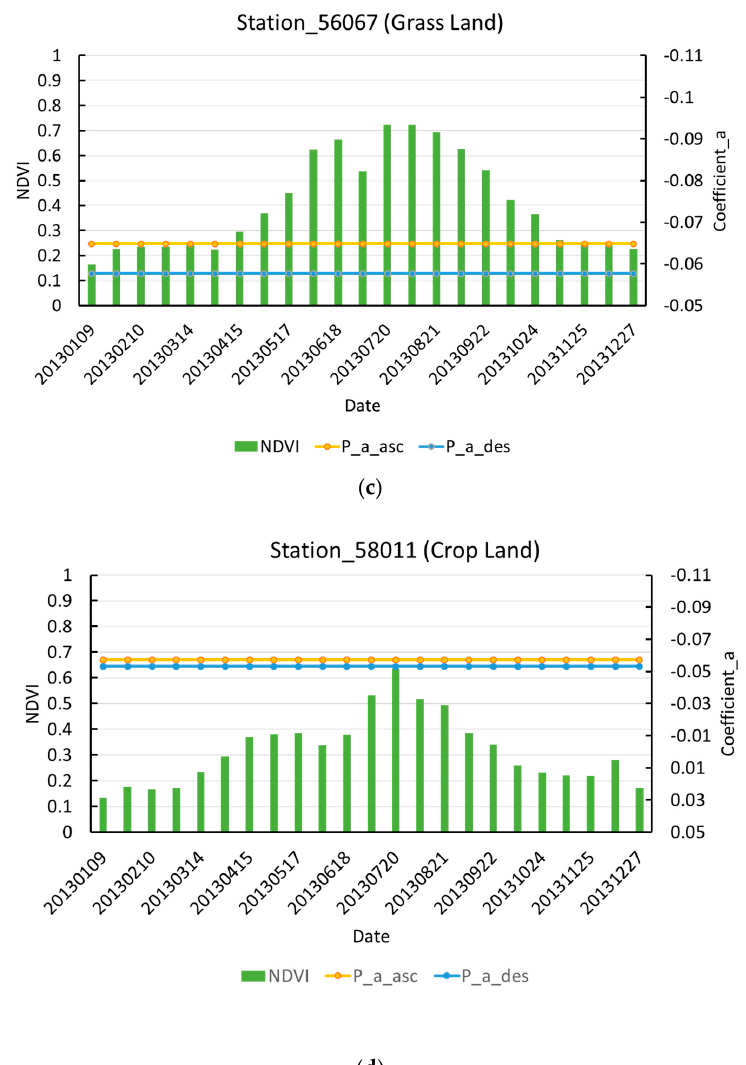
Figure A1. Parameter “a” and NDVI on forest ( a ), barren ( b ), grass land ( c ) and crop land ( d ). P_a_asc and P_a_des are for observations at 13:30 and 1:30, respectively.